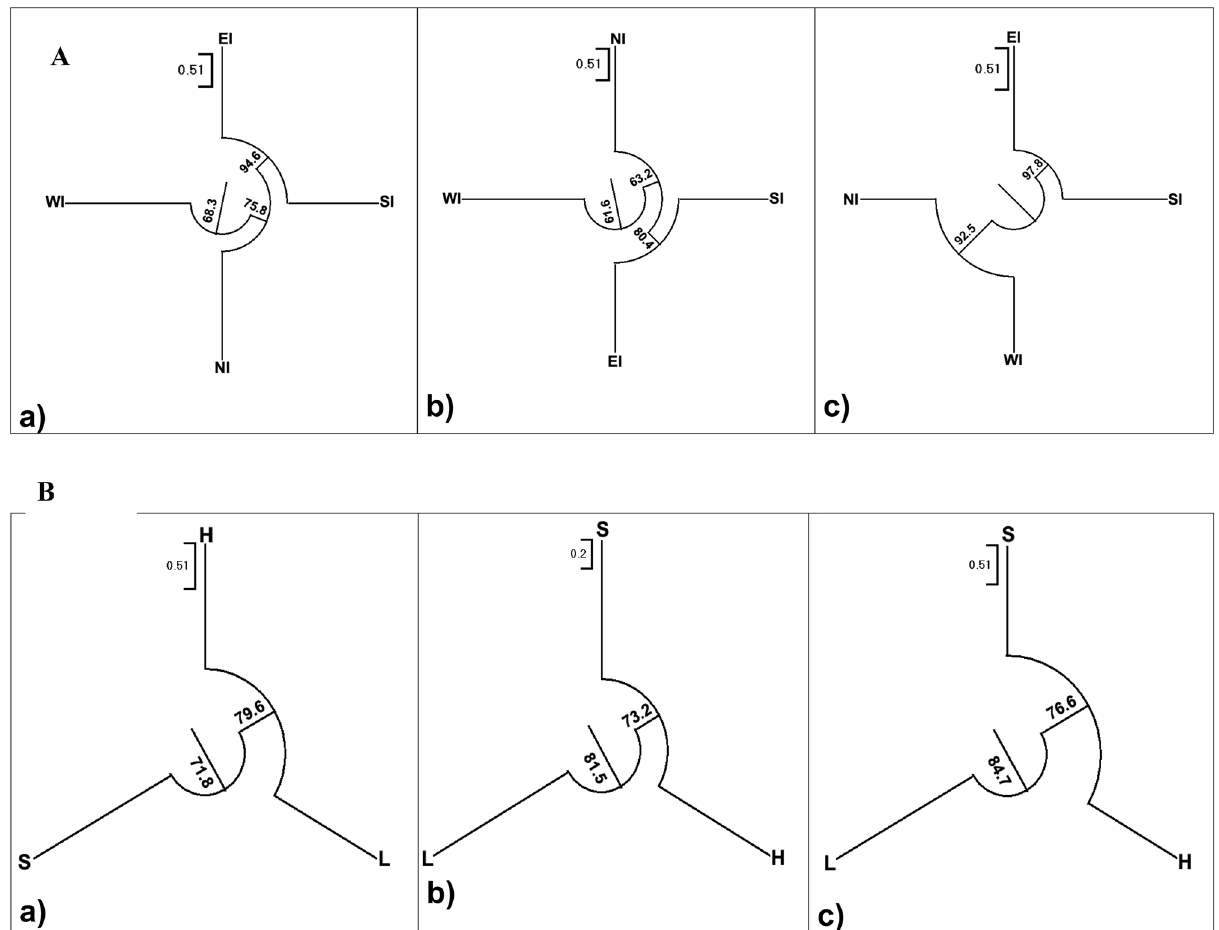
Figure 2. Neighbour joining dendrogram for ( A ) 4 different Geographic Populations (East India = EI , West India = WI, North India = NI, South India = SI) and ( B ) three different Fruit Status Populations (S = Selection, H = Hybrid and L = Landrace) of selected Indian mangoes, based on Nei’s genetic distance using DNA marker systems: ( a ) cumulative Arbitrary (RAPD + ISSR + DAMD), ( b ) cumulative Gene targeted (SCoT + CBDP) ( c )